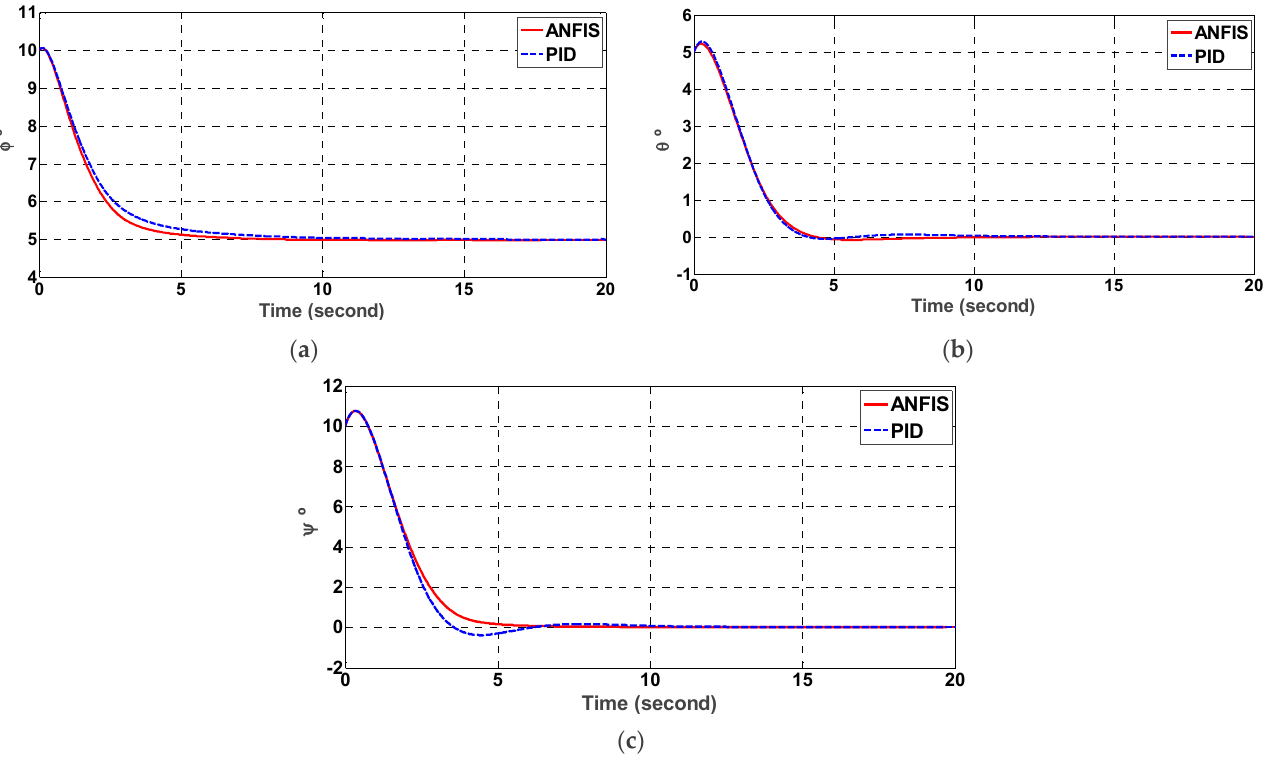
Figure 9. Comparison of Euler angles ( a ) φ , ( b ) θ , and ( c ) ψ using ANFIS and PID controllers in the presence of noise.